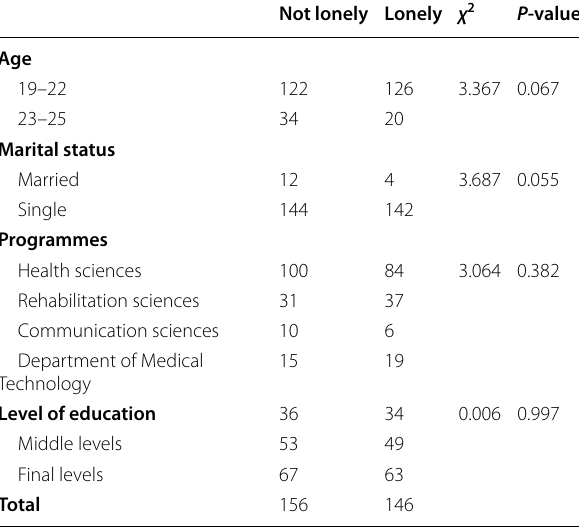
Table 6 Relationship between loneliness and the